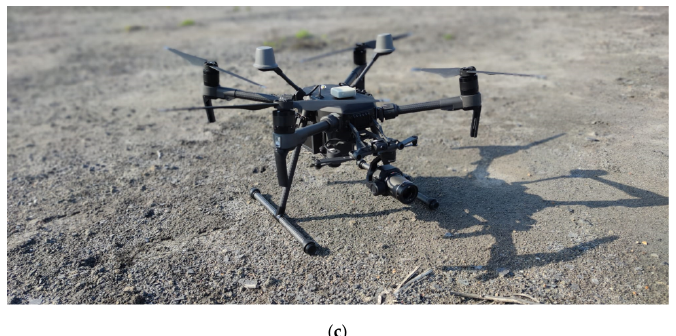
Figure 11. Slope monitoring devices: ( a ) Photo point, ( b ) GEOMAX Zenith 40 receiver, ( c ) Phantom 4 RTK Quadrocopter.